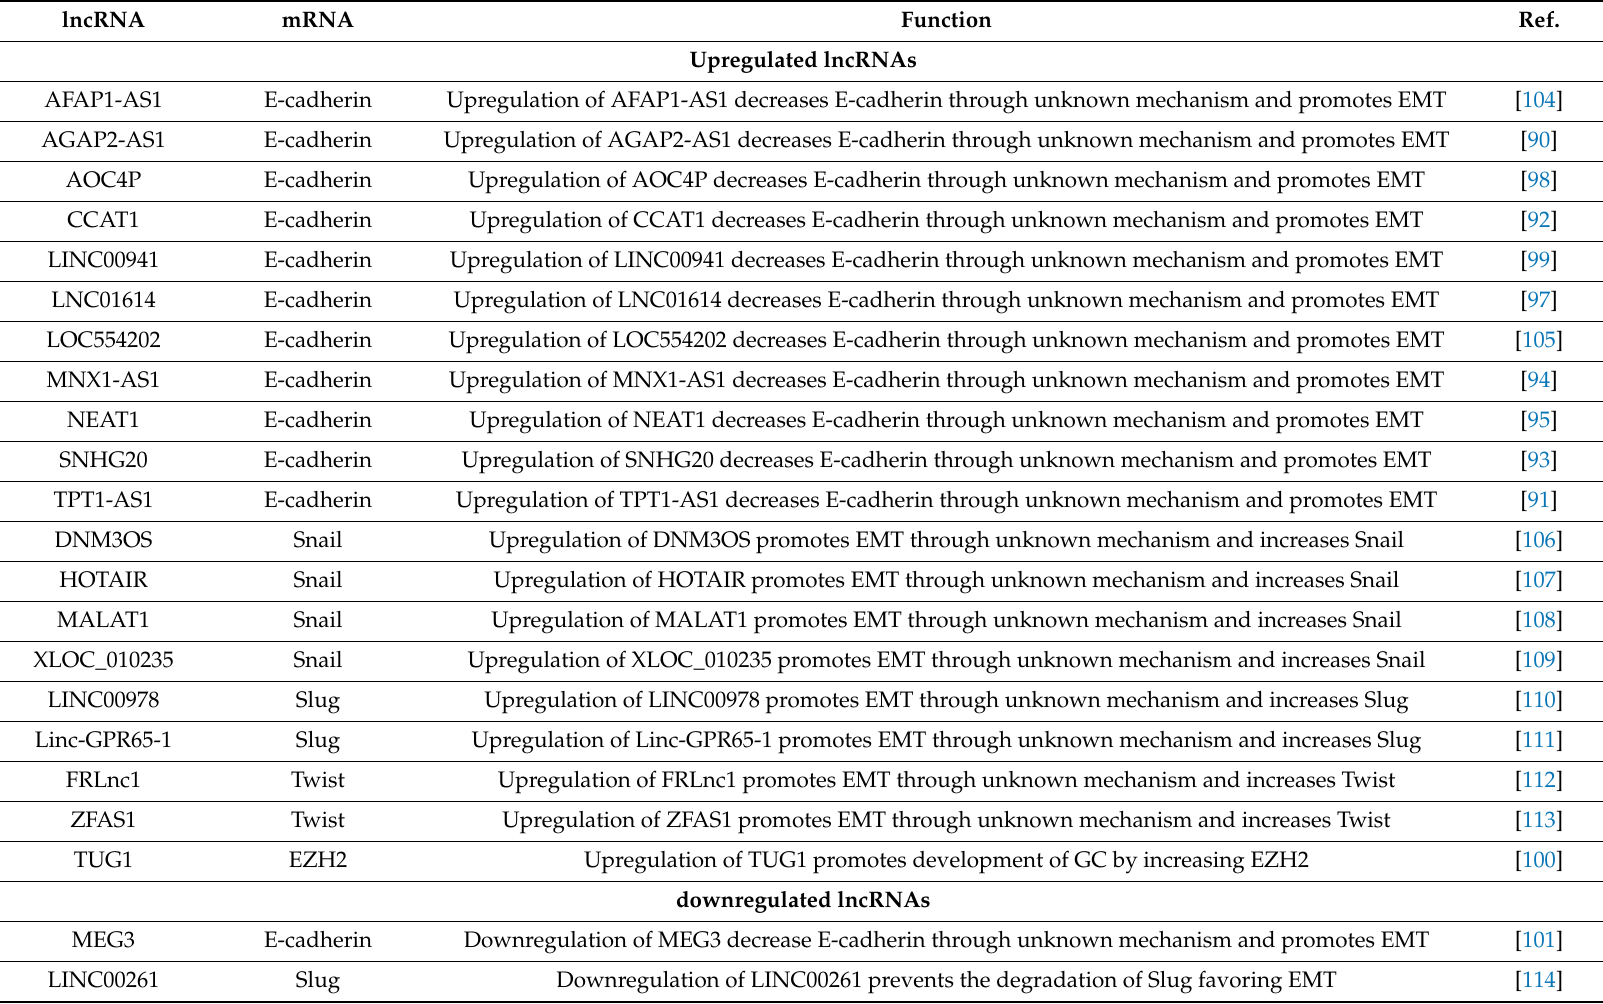
Table 2. Summary of all lncRNAs and mRNAs interactions and their roles in the EMT process associated with di ff use-type of gastric